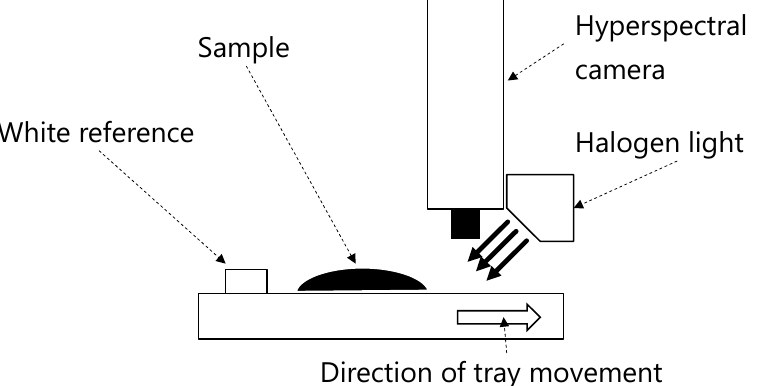
Figure 1. Basic setup of the hyperspectral imaging.